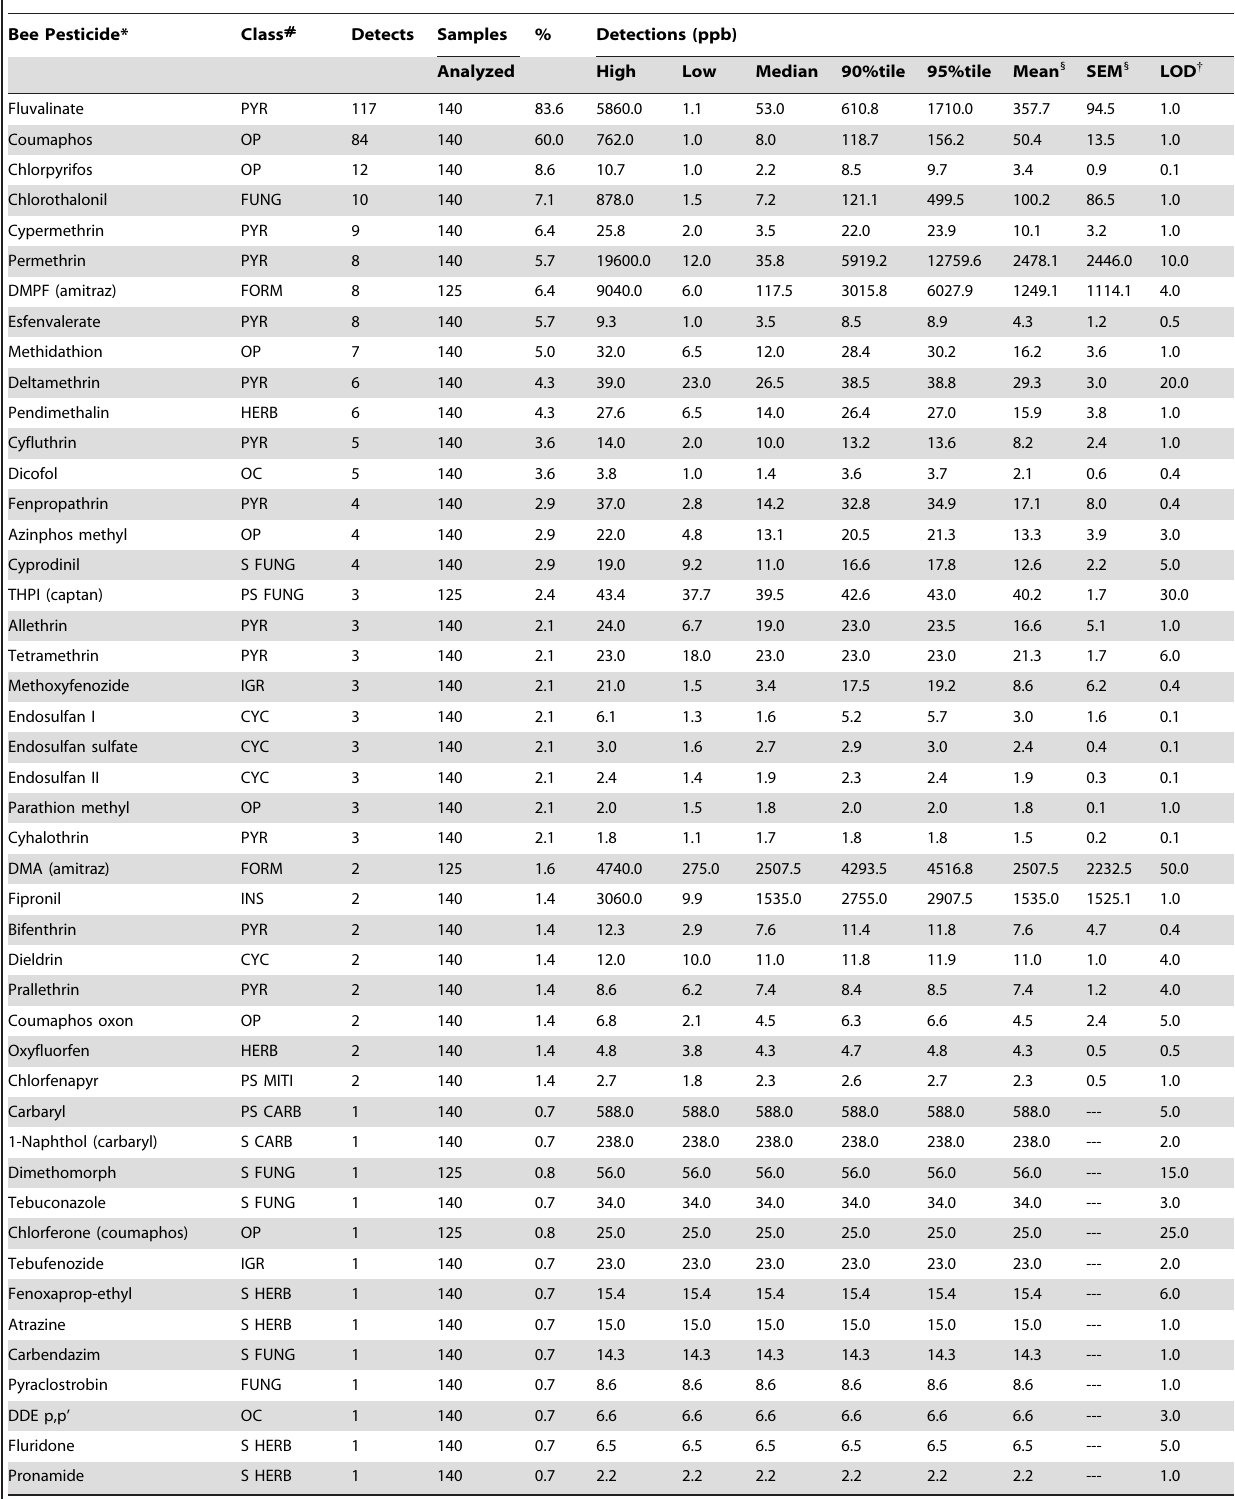
Table 3. Summary of pesticide detections in bees from North American honey bee colonies.